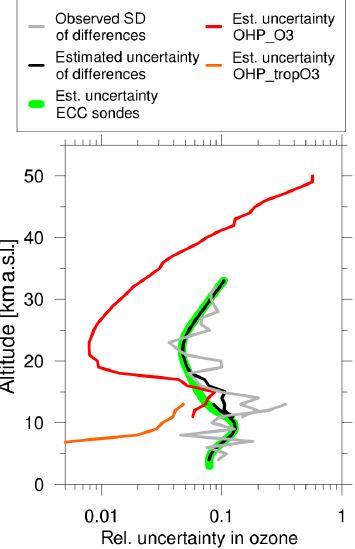
Figure 11. Vertical profiles of estimated relative ozone uncertain- ties for ECC sonde ozone profiles (green line, 2 times the esti- mate from Tarasick et al., 2016, excluding radiosonde pressure er- rors) and ozone measurement uncertainty estimated by the LiO 3 S retrieval (red line), and the LiO 3 T (orange line). Black indicates estimated combined uncertainty for the relative ozone difference between ECC sondes and the two LiO 3 S (tropospheric system up to 13km; stratospheric system above 10km). Grey indicates corre- sponding observed standard deviation for the relative ozone differ- ences during